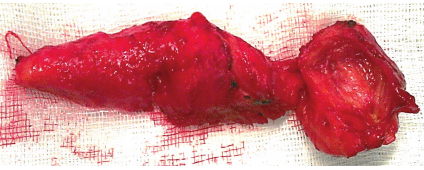
Figure 4: Siliconome and the implant